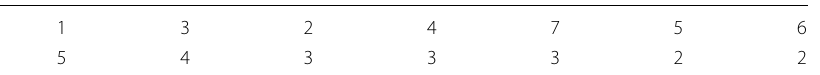
Table 1 Degree of vertices of the